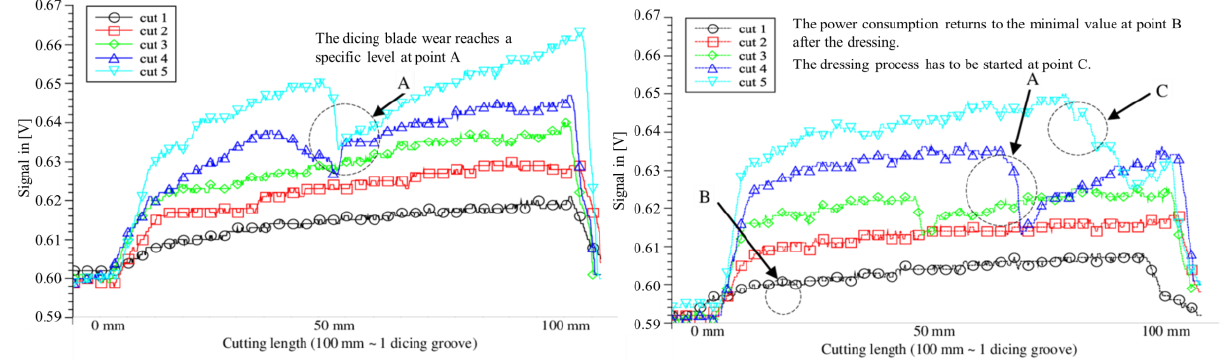
Figure 7. ( a ) Signal analysis of five cuts before laser dressing; ( b ) signal analysis of five cuts after laser dressing